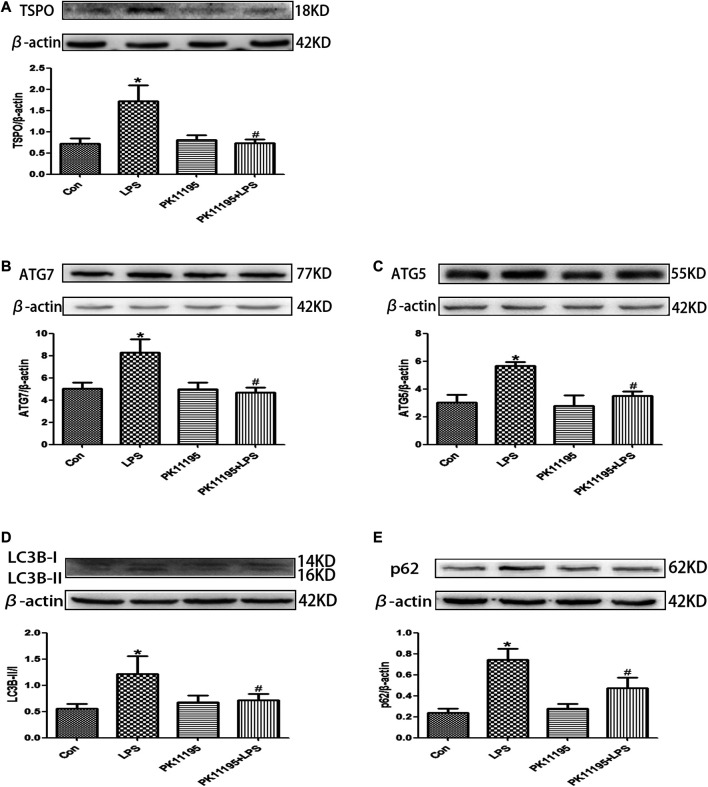
The expression of TSPO and autophagy-related proteins were quantifified by Western blotting in the hippocampus. (A) Bar graphs showing TSPO protein expressions in the hippocampus. Statistical analysis graph of each group indicating TSPO protein levels in the hippocampus; (B) Bar graphs showing ATG7 protein expressions in the hippocampus. Statistical analysis graph of each group indicating ATG7 protein levels in the hippocampus; (C) Bar graphs showing ATG5 protein expressions in the hippocampus. Statistical analysis graph of each group indicating ATG5 protein levels in the hippocampus; (D) Bar graphs showing LC3Bll/l protein expressions in the hippocampus. Statistical analysis graph of each group indicating LC3Bll/l protein levels in the hippocampus; (E) Bar graphs showing p62 protein expressions in the hippocampus. Statistical analysis graph of each group indicating p62 protein levels in the hippocampus. Values are presented as the mean ± standard deviation. *p < 0.05 vs. Con group; #p < 0.05 vs. LPS group (n = 5 in each group).